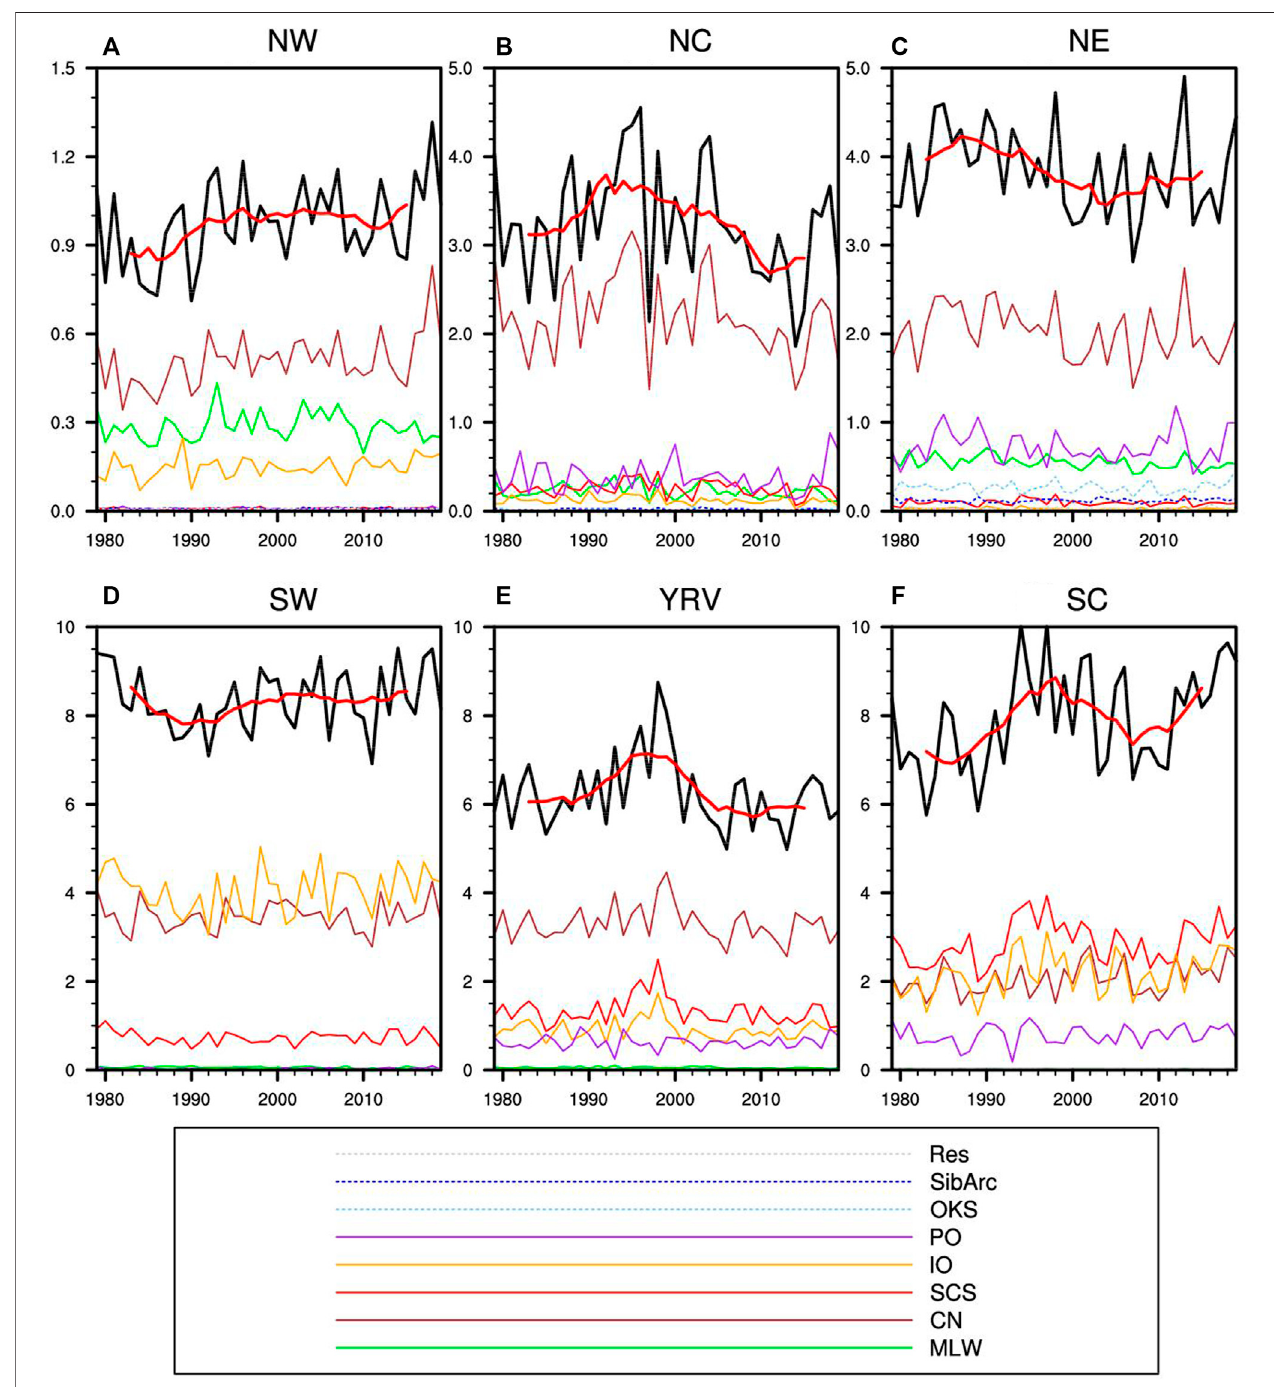
FIGURE4| Totalprecipitation(black)andtherelatedsevenmoisturesourcesprecipitation (colors)(units:mm/day)area-averagedoverthesixsubregions: (A) NW, (B) NC, (C) NE, (D) SW, (E) YRV,and (F) SC.Thethickredlinesoverlaidontheblacklinesdenotethe9-yearrunningaverageofthetotalprecipitation.Thegreen,brown, red, orange, purple, sky-blue, blue and gray lines denote the MLW, CN, SCS, IO, PO, OKS, SibArc and Res sources, respectively.